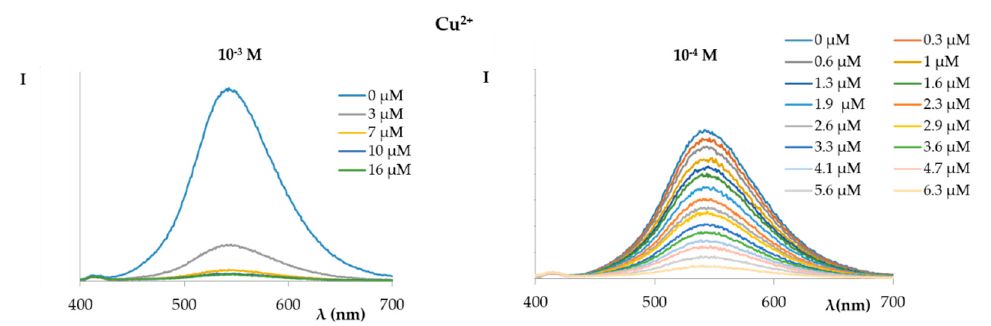
Figure 6. Fluorescence (excitation at 366 nm) spectra of compound 1 (1.72 × 10 − 5 M in EtOH:phosphate buffer) titrated with increasing amounts of a copper nitrate solution (( left ) 1.0 × 10 − 3 M; ( right ) 1.0 × 10 − 4 M).